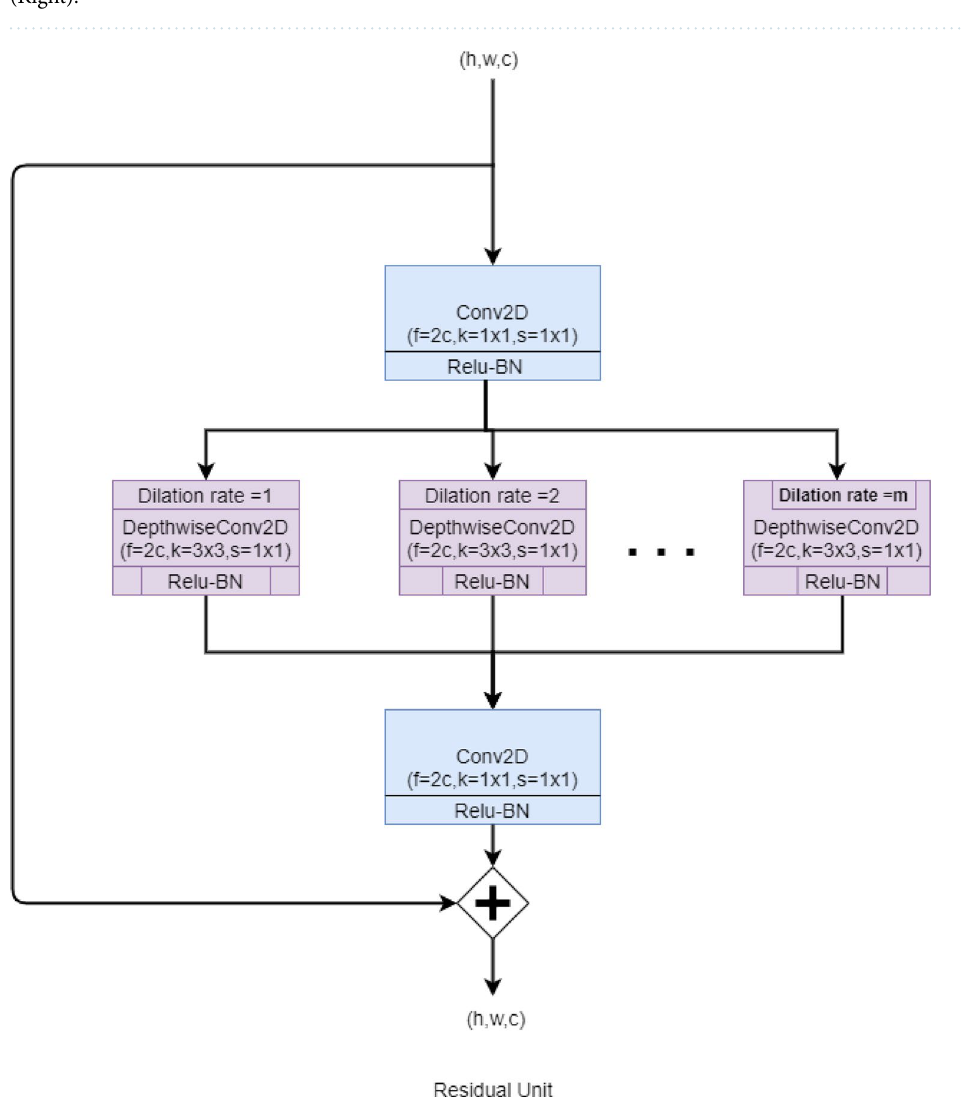
Figure 4. The basic block diagram of the Residual Unit of the proposed IRFacExNet model. Image is developed using Draw.io 32